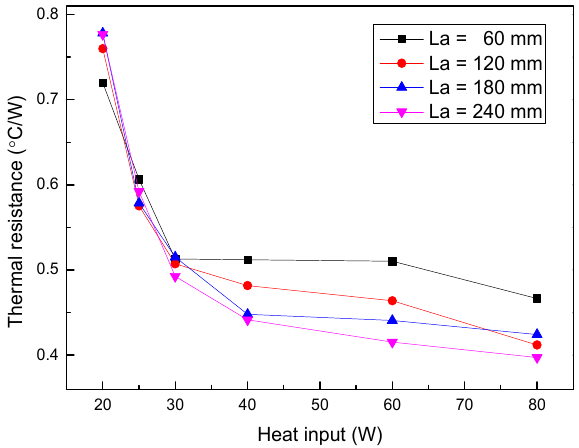
Figure 13. The thermal resistance of the PHP varied with the heat